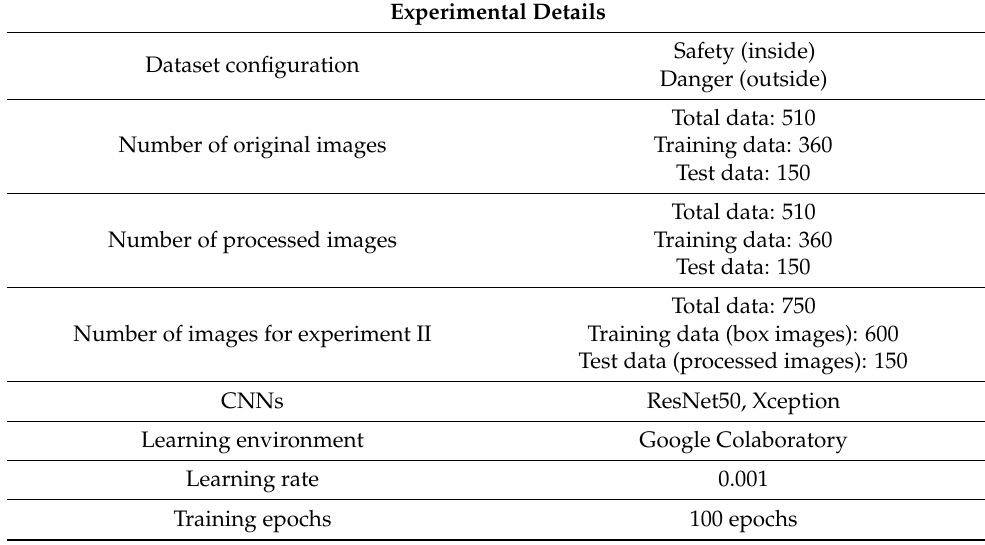
Table 2. Experimental details for Training CNN; ResNet50 and Xception.